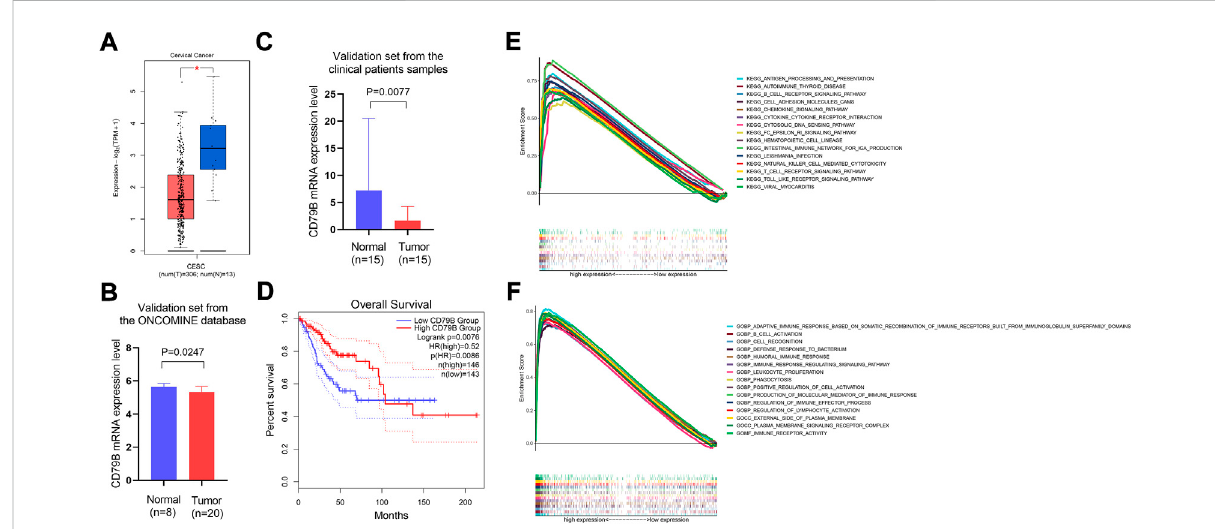
FIGURE 4 DifferentialexpressionofCD79B,survivalanalysis,andGSEAanalysisofhighlyexpressedCD79B. (A) ThemRNAexpressionlevelofCD79BinCC tissues and normal tissues was analyzed using the GEPIA2 online datasets. These datasets included 13 normal samples from the TCGA and GTEx databases, respectively, as well as 306 tumor samples from the TCGA database (* p < 0.05). (B) mRNA expression of CD79B in CC tissues and normal tissues from the ONCOMINE database. (C) The mRNA expression of CD79 B was examined in CC tissues and compared to normal tissues by qRT-PCRusing 30samplesfrom patients. Anunpaired t -testwith Welch ’ scorrection evaluated thesigni fi cance ofthedata. (D) Association between CD79B expressionand overall survival in CC, based on theGEPIA2 online database. (E and F) GSEA analysisof the top 15 signi fi cant pathways (E) and enriched gene sets in c5. go.v7.4. Symbols (F) associated with high CD79B